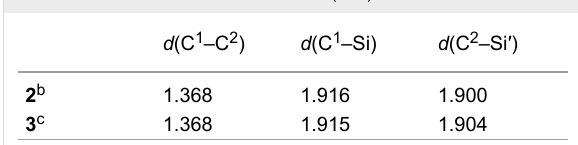
Table 1: Selected interatomic distances (in Å) of 2 and 3 .